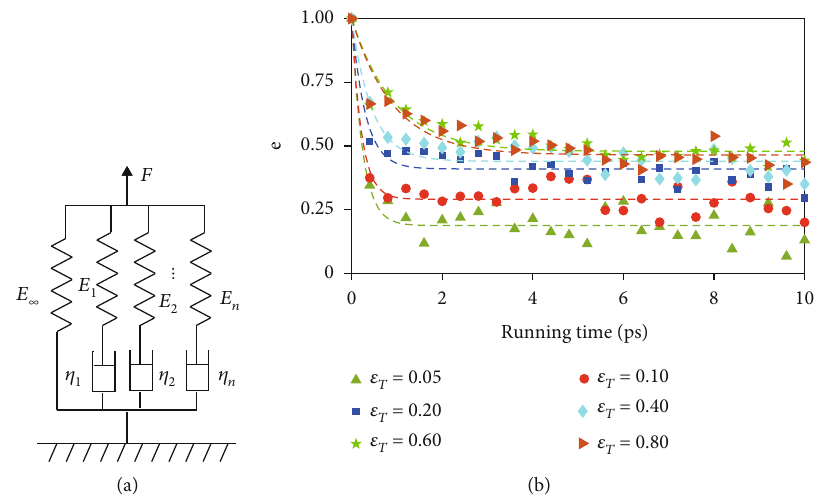
Figure 11: (a) Schematic diagram of the general Maxwell model and (b) the comparison of the nondimension relaxation modulus between simulation results (the scatter points) and theoretical values (the dashed lines) at ε out.